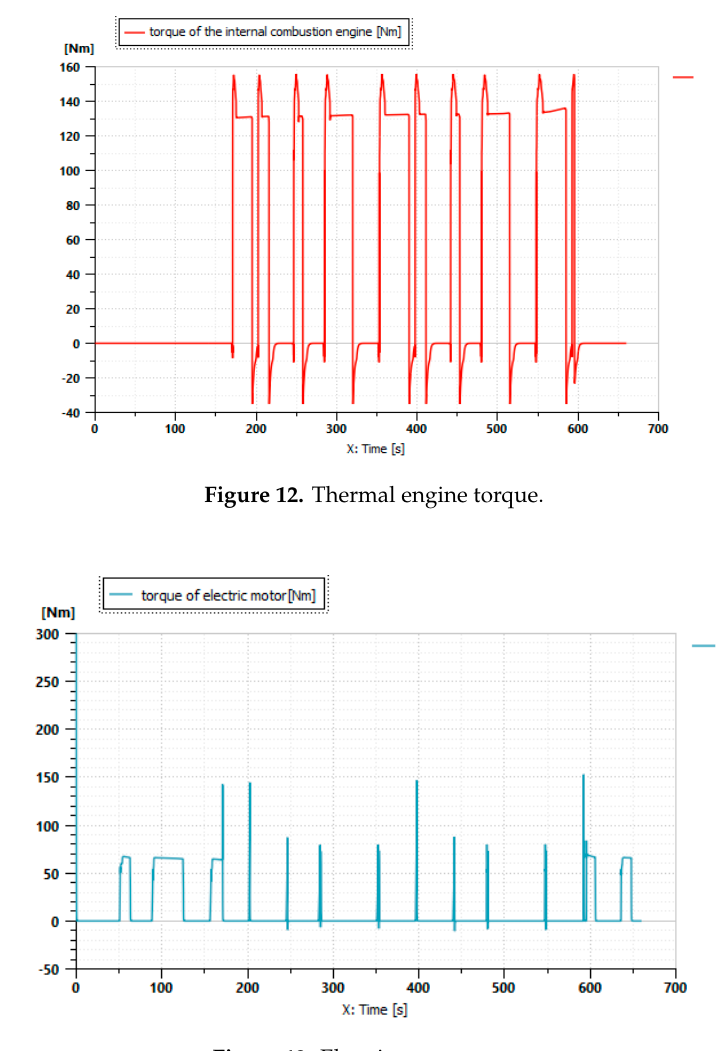
Figure 11. Tractor driving cycle with a moldboard plow attached.